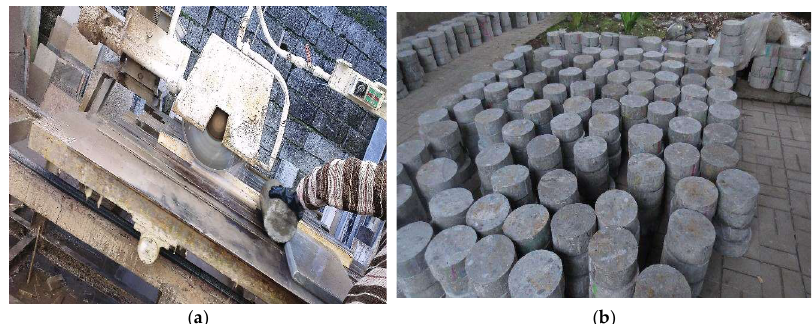
Figure 7. Cut samples ( a ) cutting machine ( b ) concrete disc specimens.